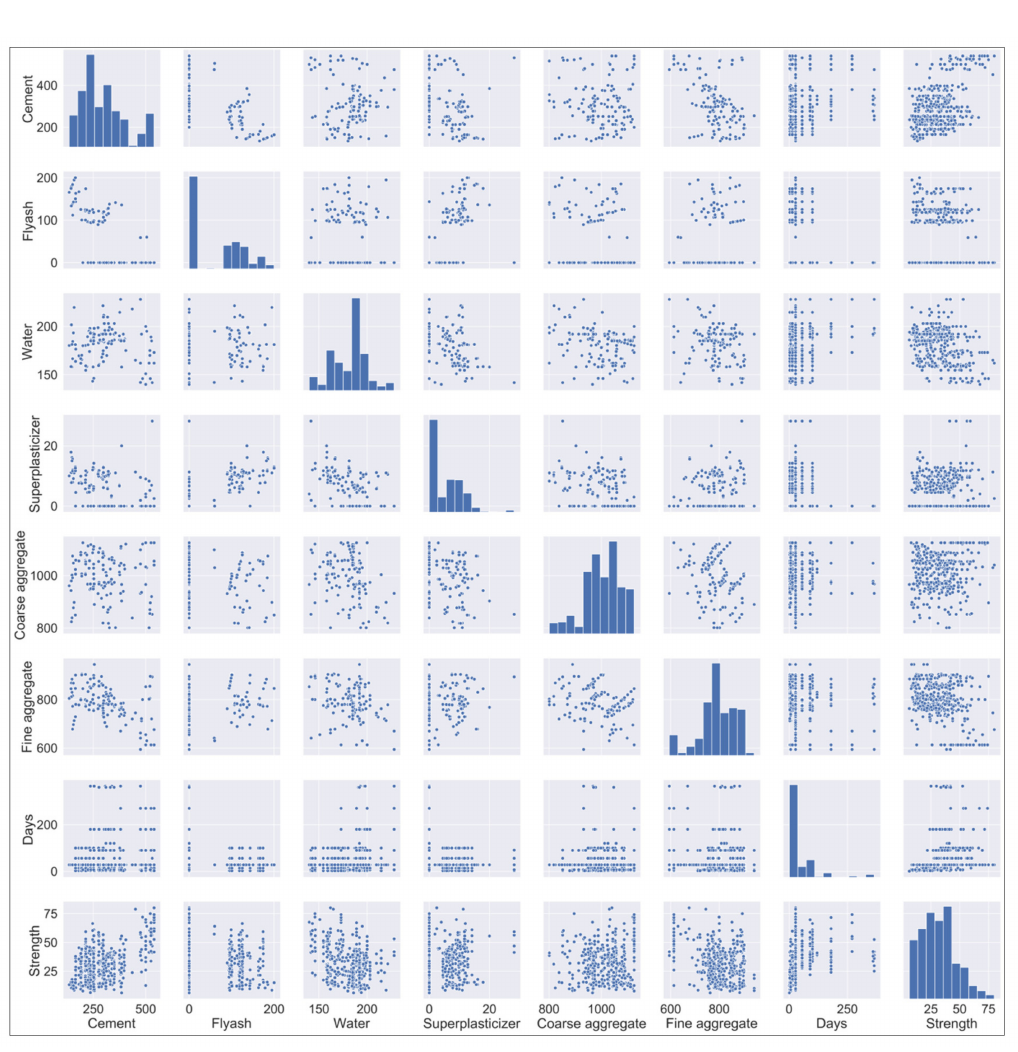
Figure 1. Variable relationship with compressive strength.